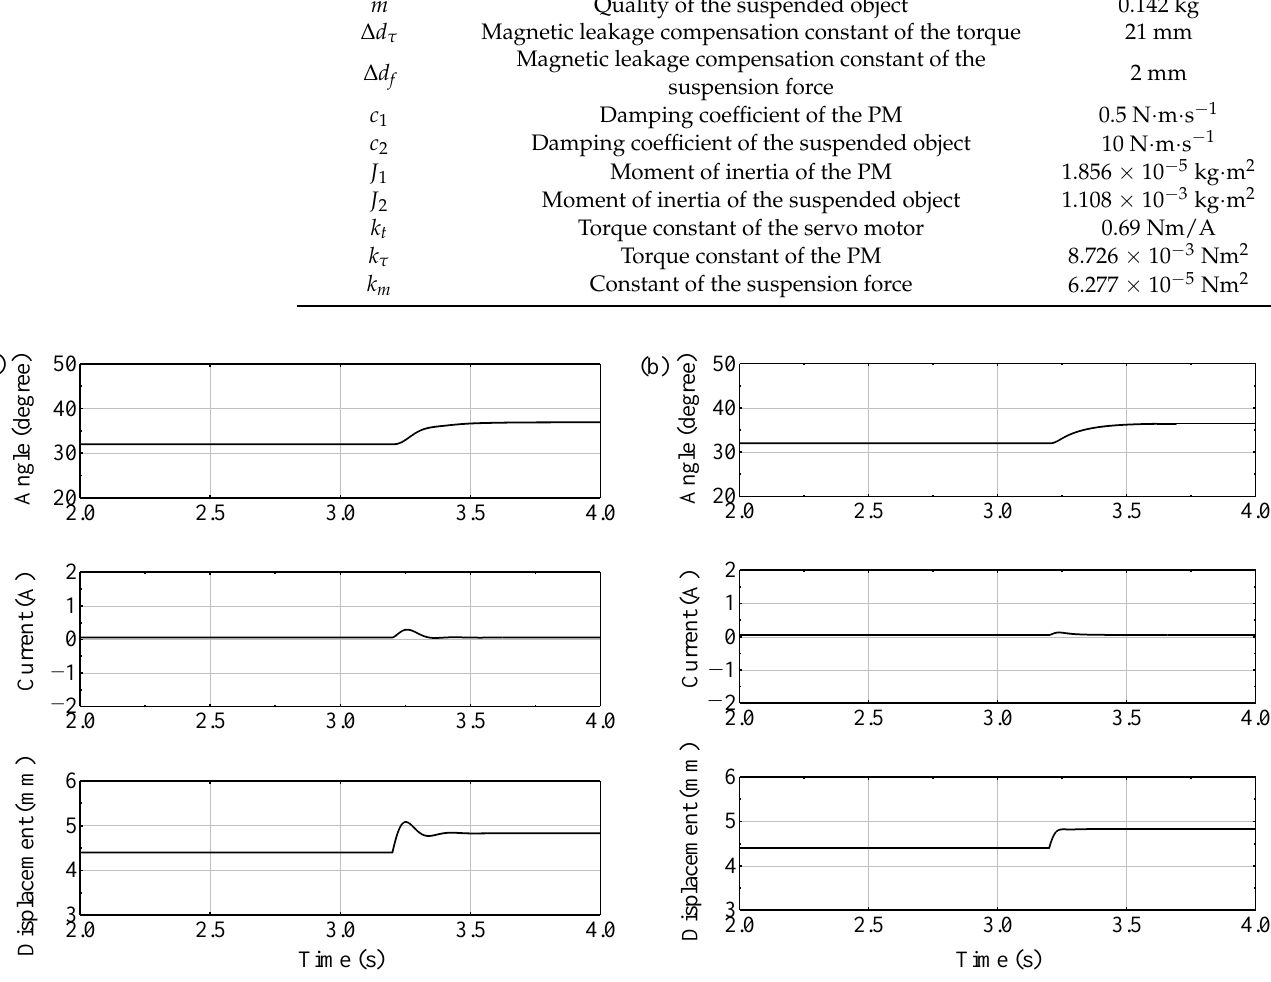
Figure 5. Simulation results of the displacement disturbance: ( a ) position loop fuzzy cascade control; ( b ) angle loop fuzzy cascade control.